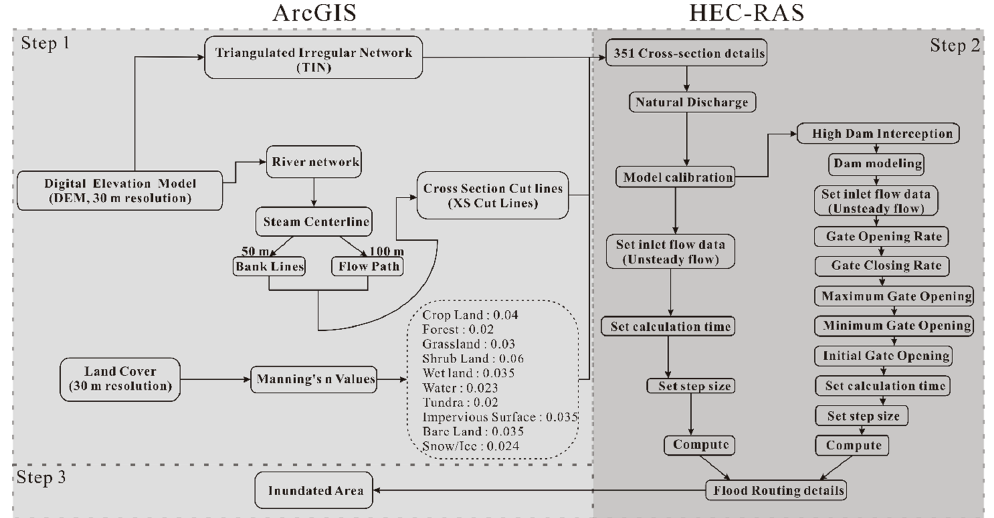
Figure 2. The flow chart illustrates the method used to simulate the flood process under natural discharge and high dam interception (ArcGIS is software of Geographic Information System; HEC-RAS is a tool of flow modeling).